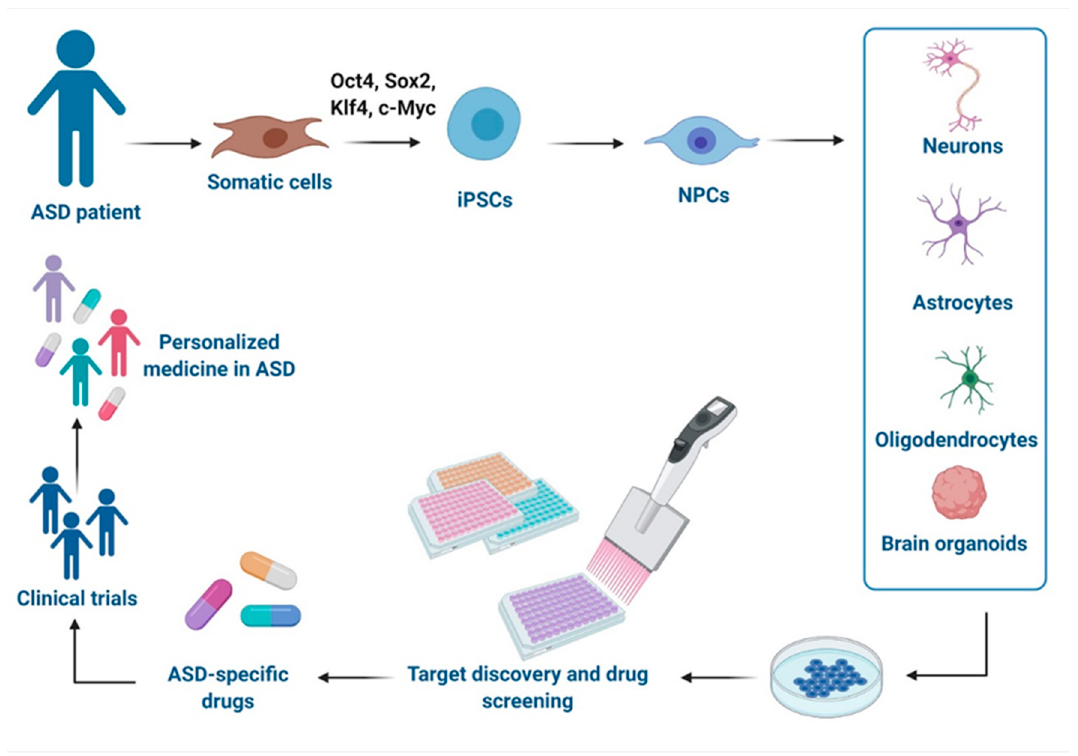
Figure 1. Schematic representation of disease modeling and drug discovery with iPSCs in Autism spectrum disorder (ASD). Specific iPSCs can be derived from somatic cells of ASD individuals and can be further differentiated into different cells types of the central nervous system (CNS) or organized in brain organoids for drug discovery in vitro, development of new drugs, and clinical trials, leading to a personalized medicine for ASD. This figure was created with BioRender.com (accessed on 11 February 2021).